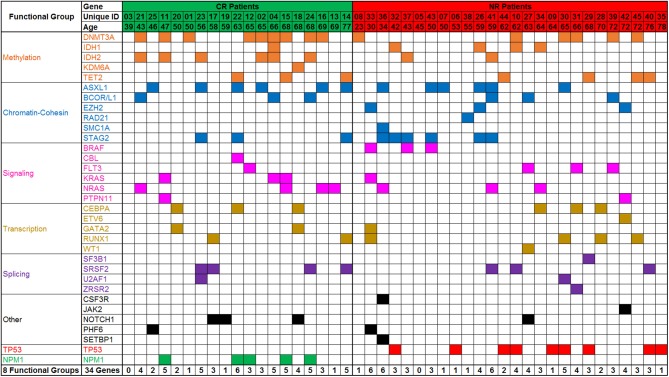
Targeted DNA sequencing of AML patient blood from day 1 of treatment. Variants were detected in 43 of 45 patients assessed. A total of 162 variants were identified in 34 genes or gene regions of 49 assessed. Genes with variants are grouped by gene function/class. Frequency of mutations and patterns of co-mutation are consistent with previous reports. CR, complete remission; NR, non-responder.